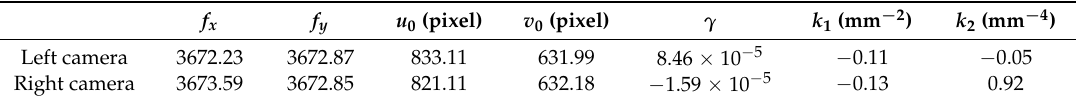
Table 1. Intrinsic parameter calibration results of left and right cameras by Zhang’s method.